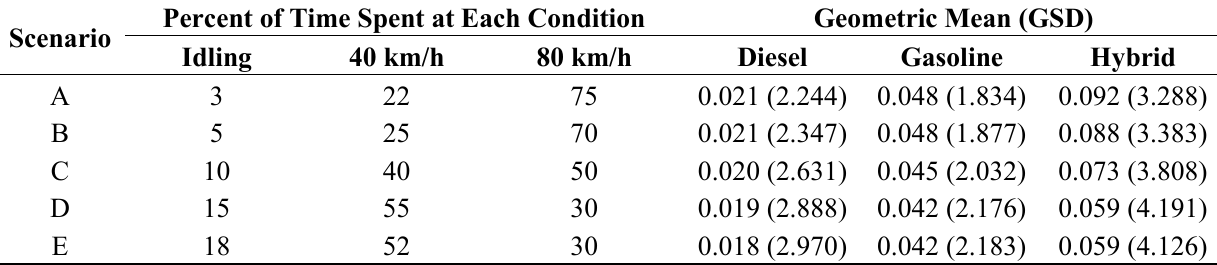
Table 5. Estimates of Magnetic fields (μT) for typical driving scenarios stratified by engine